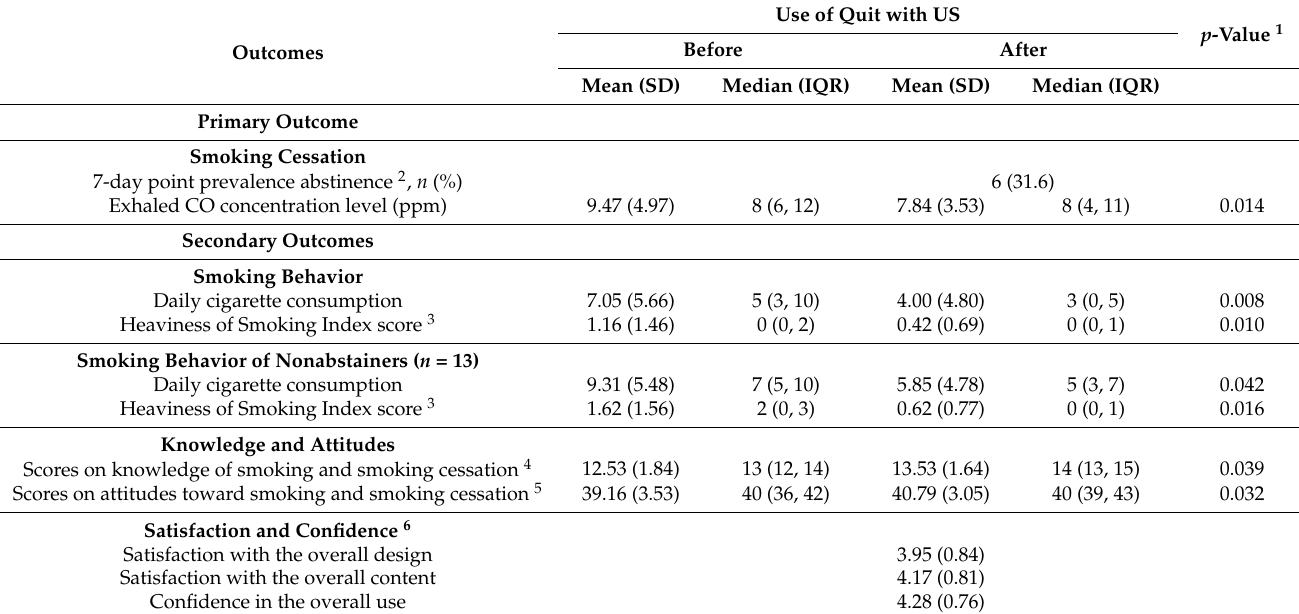
Table 2. Comparison outcomes before and after using Quit with US for 4 weeks of 19